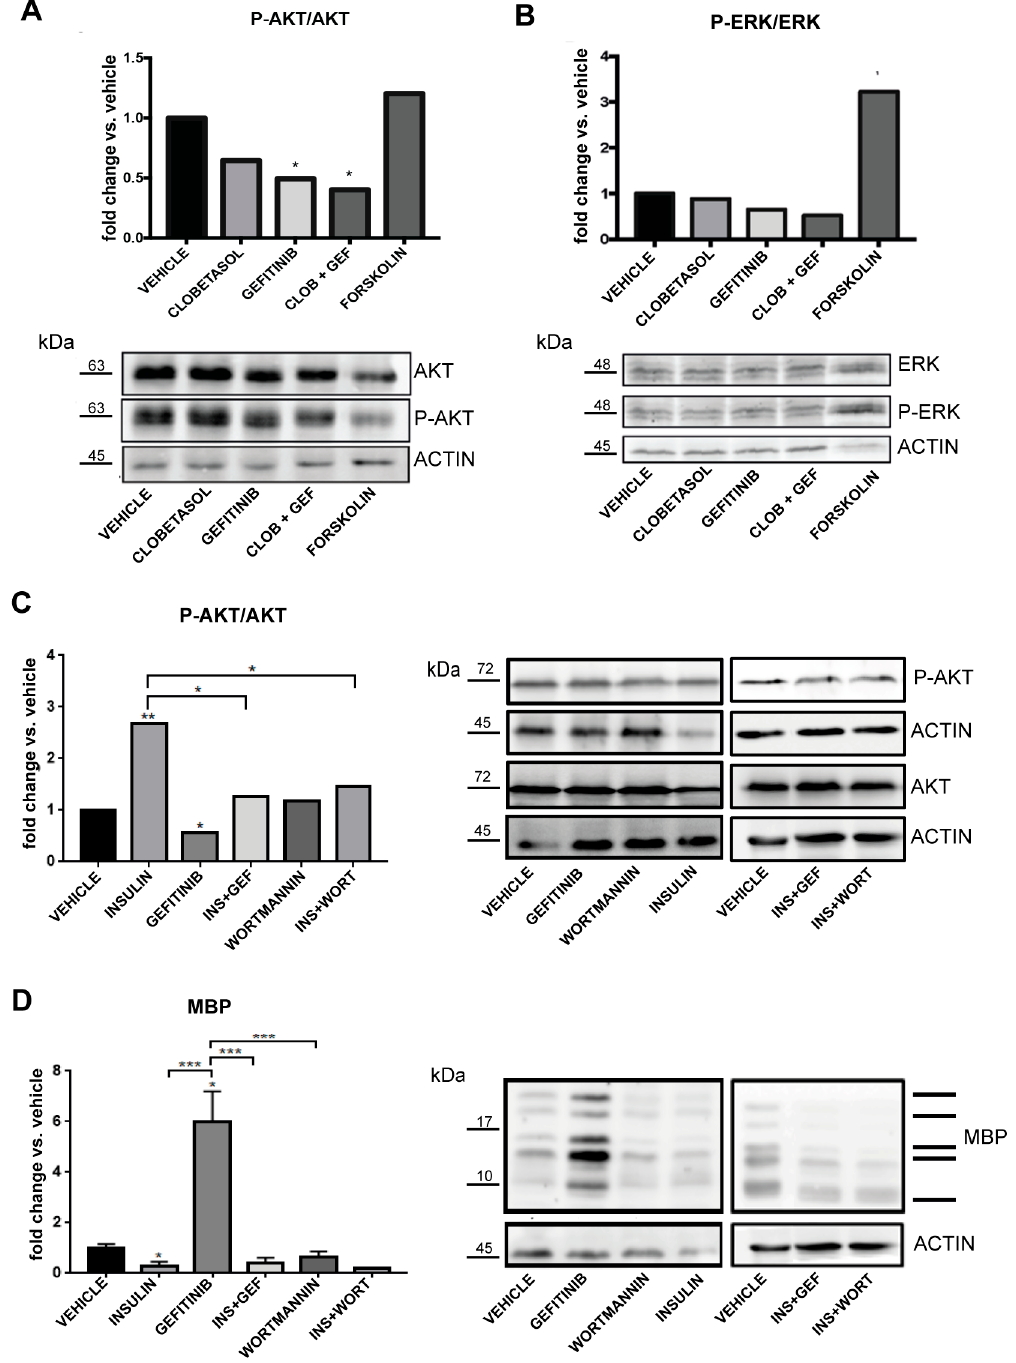
Figure 4. Analysis of the signaling pathways activated by Gefitinib treatment in Oli-neuM cells. ( A , B ) Immunoblot analysis Oli-neuM cell extracts after treatment with 1 µ M Gefitinib, 5 µ M Clobetasol, 5 µ M Forskolin (as control treatment), or vehicle (DM + 0.5% DMSO). Quantitative analysis of protein levels: ( A ) top panel: anti-AKT (AKT) or phospho-AKT (P-AKT) antibody. Anti-actin antibody was used to normalize sample loading. (n = 3). Signal intensity was estimated on bands using ImageJ software tools, and data were plotted using GraphPad Prism as the fold change of P-AKT / AKT. A 2-fold change threshold versus vehicle was applied (indicated with *). Lower panel: representative image of immunoblots used for quantitative analysis. ( B ) Top panel: anti-ERK (ERK) or anti-phospho-ERK (P-ERK) antibody. Data and statistical analyses (n = 3) were performed as in ( A ). Lower panel: representative image of immunoblots used for quantitative analysis. ( C , D ) Immunoblot analysis of Oli-neuM cell